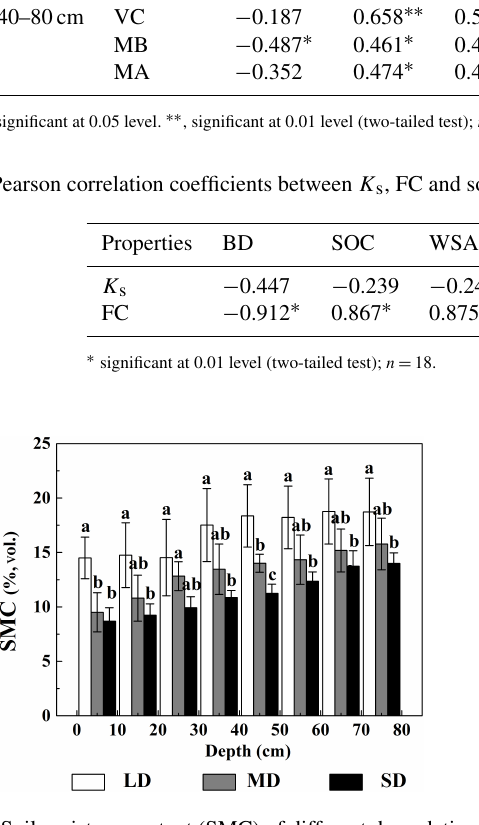
Figure 5. Soil moisture content (SMC) of different degradation de- grees. Error bars denote the standard deviation of the three sites of the same degradation degree. Bars with the same letter indicate that no significant differences ( p < 0.05) exist between correspond- ing degradation degrees. LD: lightly degraded, MD: moderately de- graded, SD: severely